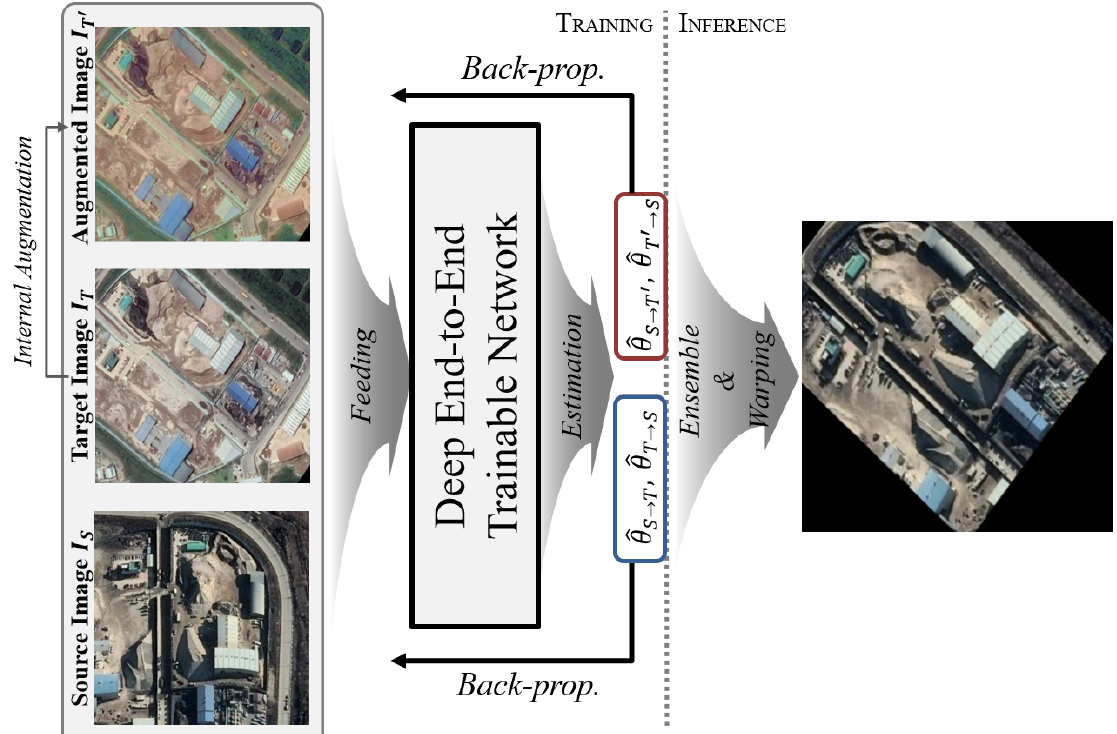
Figure 3. Overview of the proposed network. Our network directly estimates the outcomes ˆ θ ˆ θ ˆ θ ˆ θ ( ˆ θ ) , where ˆ θ S → T , T → S , S → T (cid:48) , T (cid:48) → S S → T and T → S are the global transformation parameters that transform I S to I T , vice versa, and (ˆ θ S → T (cid:48) , ˆ θ T (cid:48) → S ) are those between I S and I T (cid:48) . Subsequently, the outcomes are employed for the backpropagation in the training procedure. In the inference procedure, we warp I S to I T using the final ensembled